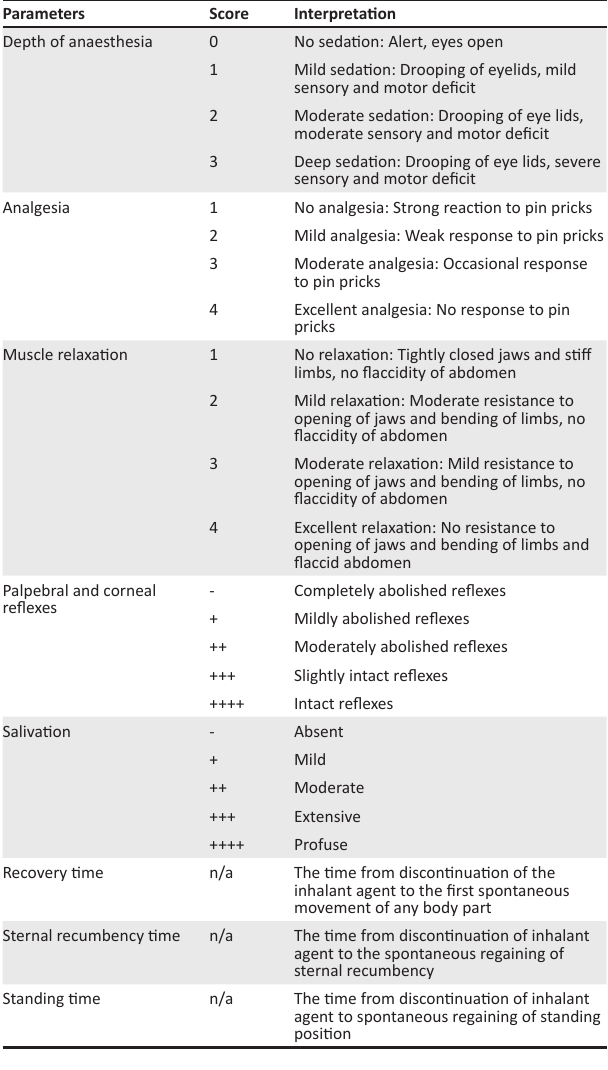
TABLE 1: Parameters used for clinical monitoring of